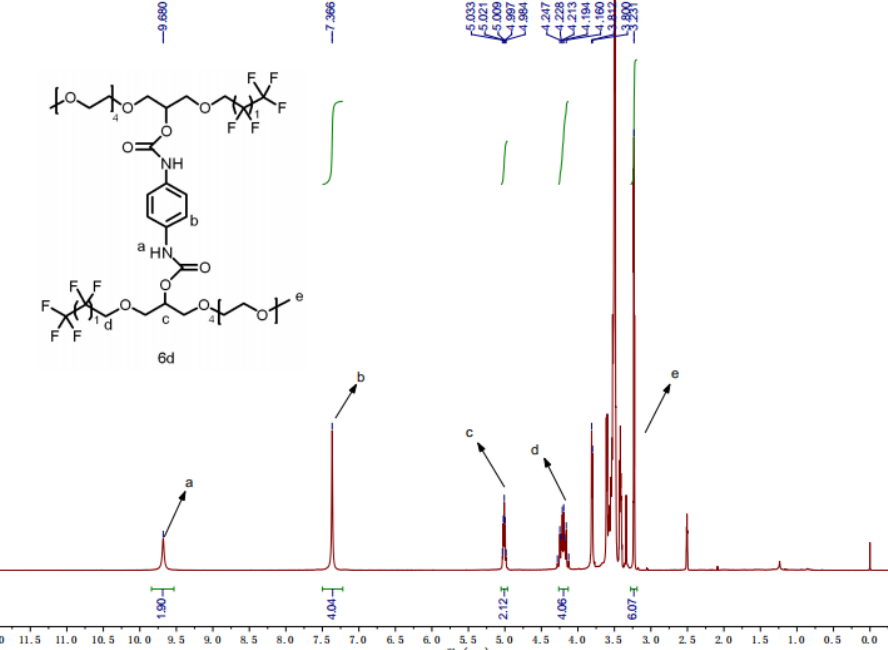
Figure 3. 1 H NMR spectrum of 6d .